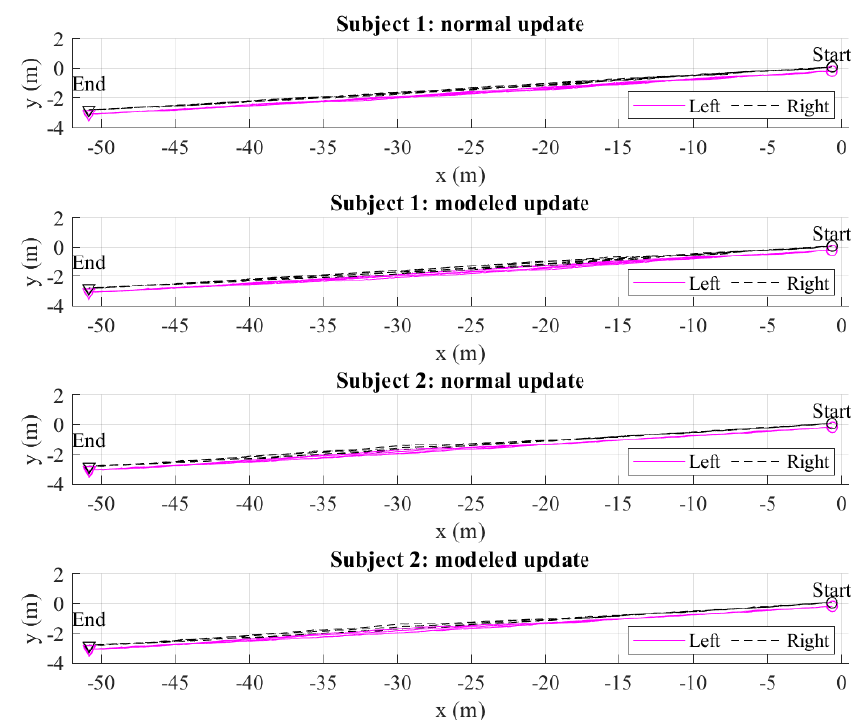
Figure 11. The total estimated 50 m walking trajectories of two subjects from the smoother algorithm in the normal and modeled update.